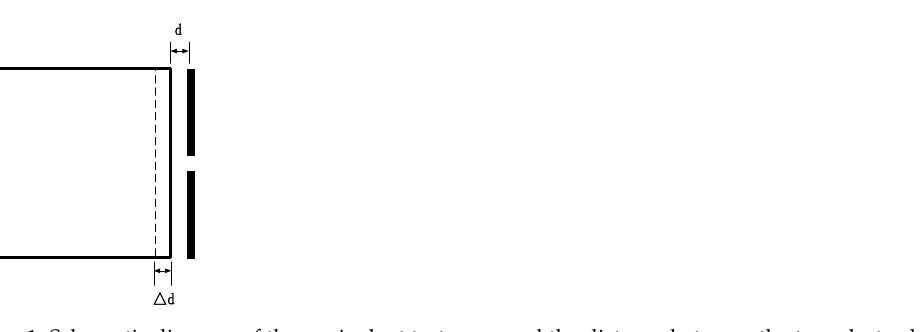
Figure 1. Schematic diagram of the equivalent test mass and the distance between the two electrodes being equal.